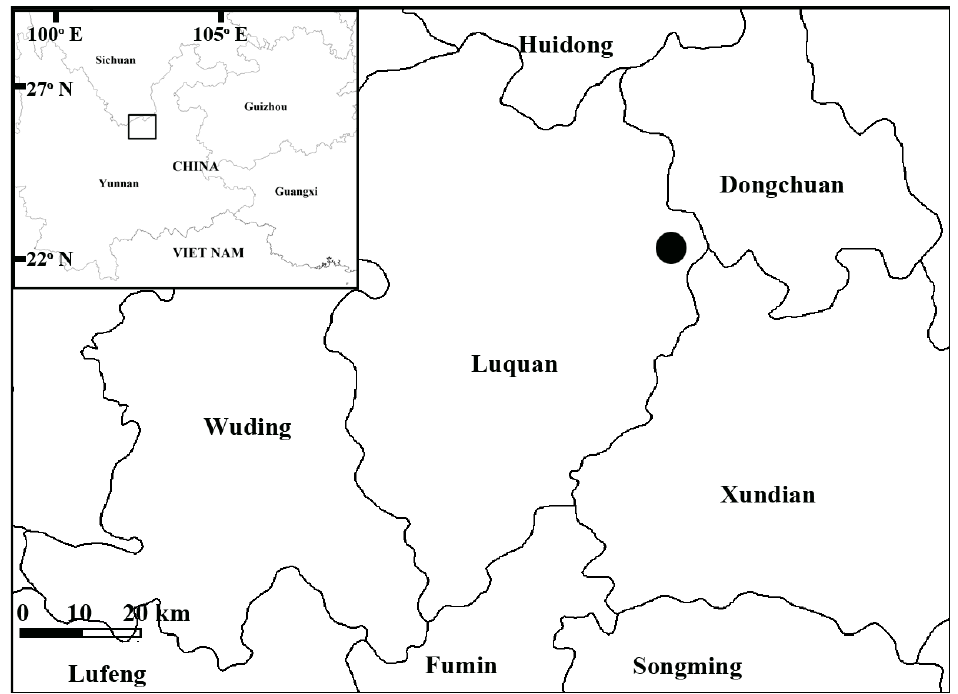
Figure 3. Known distribution of Primula